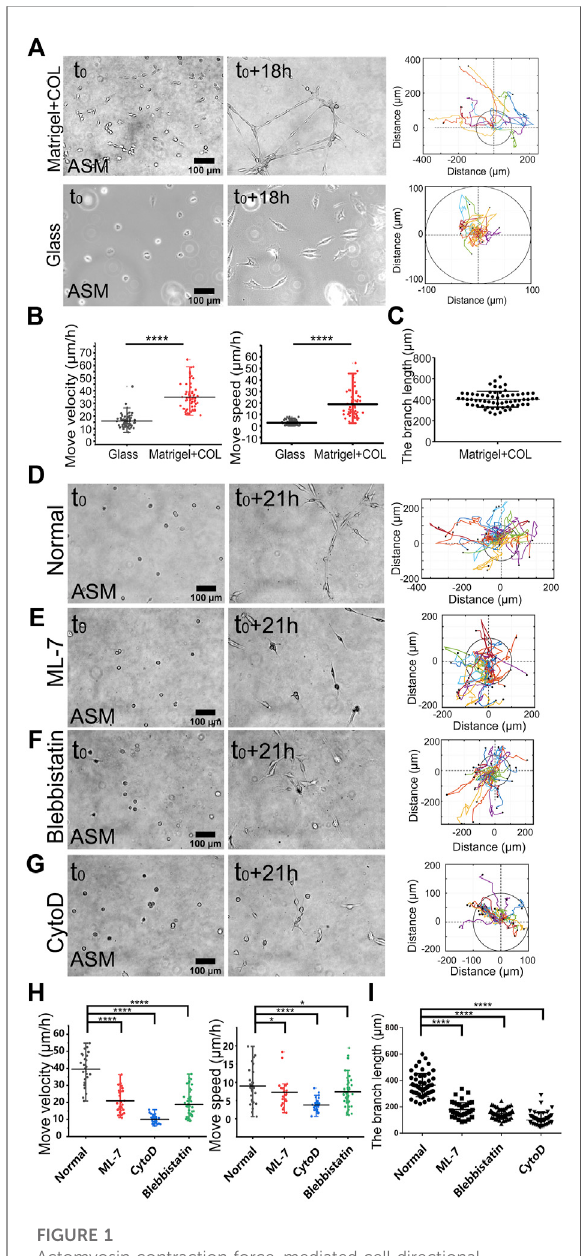
FIGURE 1 Actomyosin contraction force-mediated cell directional migrations during network assembly on the hydrogel. The hydrogel refers to 3D Matrigel containing 0.5 mg/ml COL in this